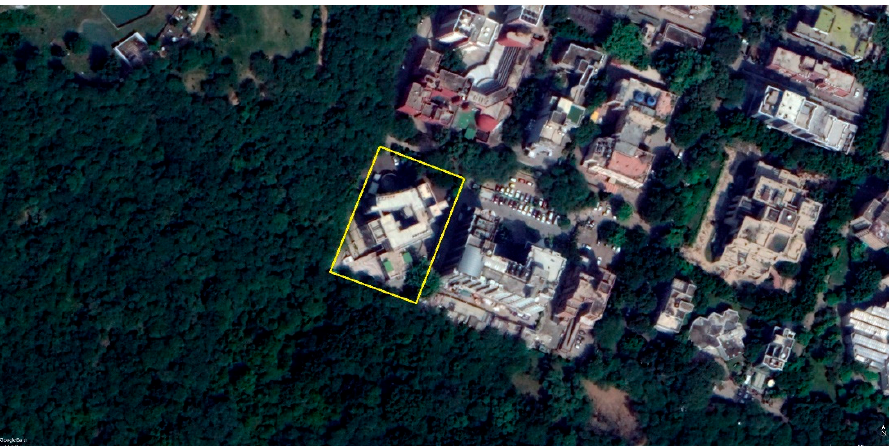
Figure 22. Satellite image of the Development Alternatives (DA) building located on the south-western corner of Qutab Institutional Area (Image courtesy of Google Earth).